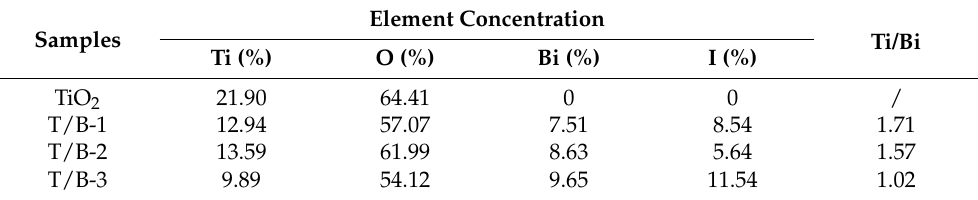
Table 1. Summary of elements contents of TiO 2 , T/B-1, T/B-2, and T/B-3 composite fibers. Samples